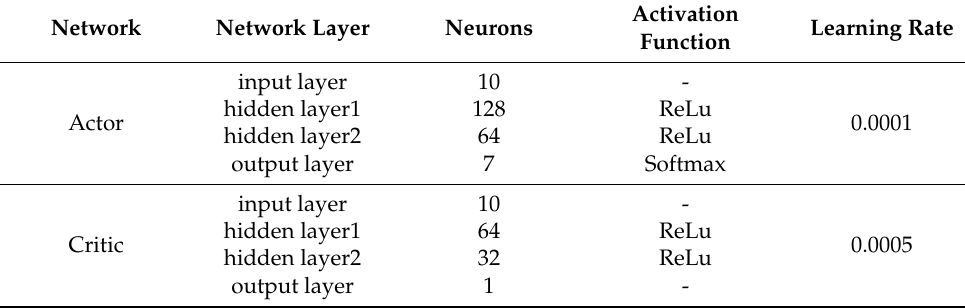
Table 3. Actor–Critic Network